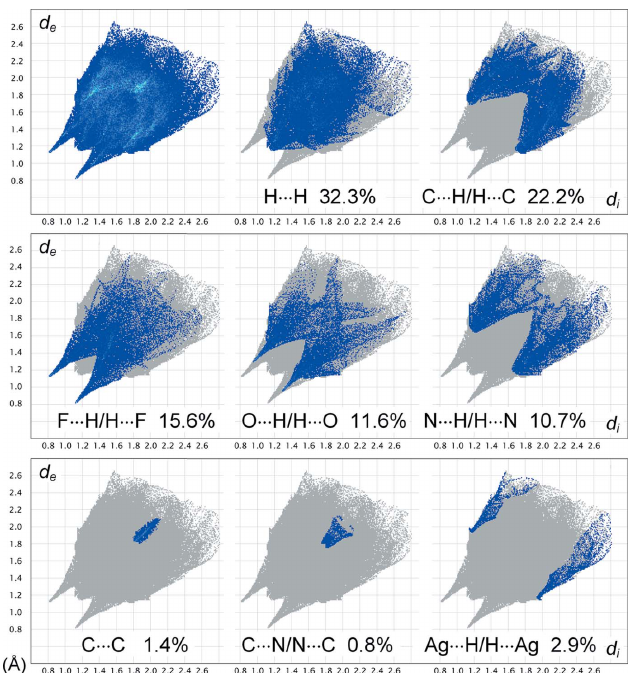
Figure 5 Two-dimensional fingerprint plots for the title compound, and those delineated into the principal contributions of H (cid:2)(cid:2)(cid:2) H, C (cid:2)(cid:2)(cid:2) H/H (cid:2)(cid:2)(cid:2) C, F (cid:2)(cid:2)(cid:2) H/H (cid:2)(cid:2)(cid:2) F, O (cid:2)(cid:2)(cid:2) H/H (cid:2)(cid:2)(cid:2) O, N (cid:2)(cid:2)(cid:2) H/H (cid:2)(cid:2)(cid:2) N, C (cid:2)(cid:2)(cid:2) C, C (cid:2)(cid:2)(cid:2) N/N (cid:2)(cid:2)(cid:2) C and Ag (cid:2)(cid:2)(cid:2) H/H (cid:2)(cid:2)(cid:2) Ag contacts. Other observed contacts are N (cid:2)(cid:2)(cid:2) N (0.4%), C (cid:2)(cid:2)(cid:2) F/F (cid:2)(cid:2)(cid:2) C (0.1%) and C (cid:2)(cid:2)(cid:2) O/O (cid:2)(cid:2)(cid:2) C